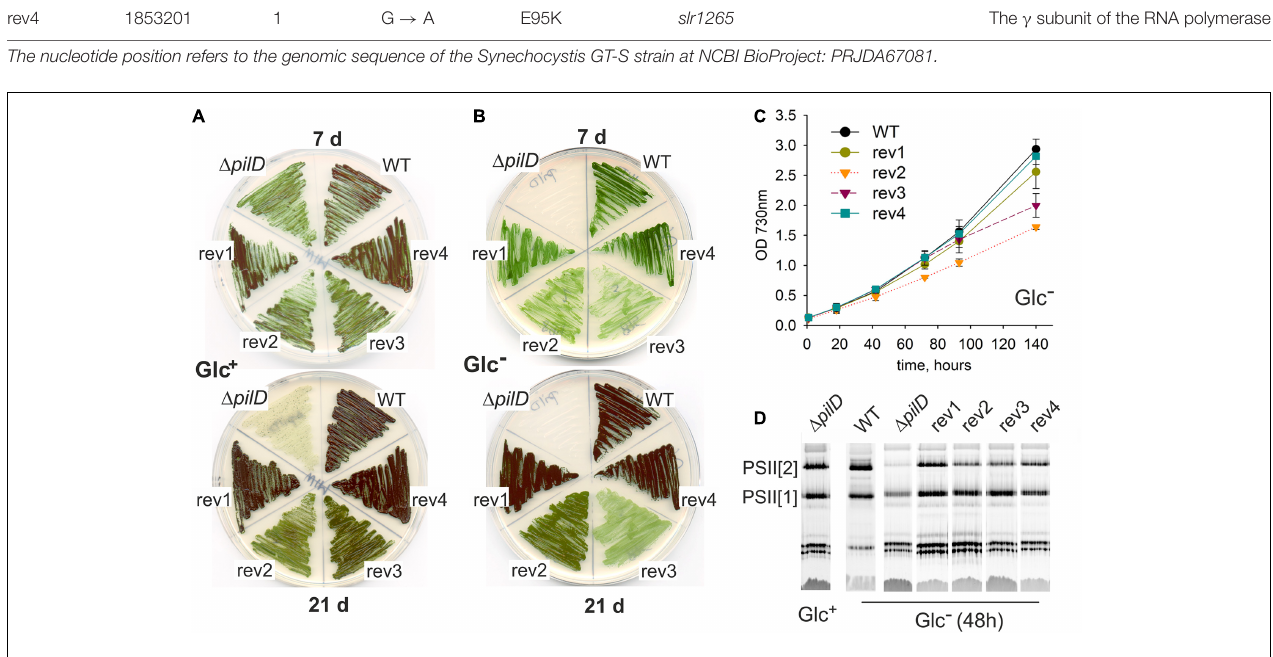
The γ subunit of the RNA polymerase